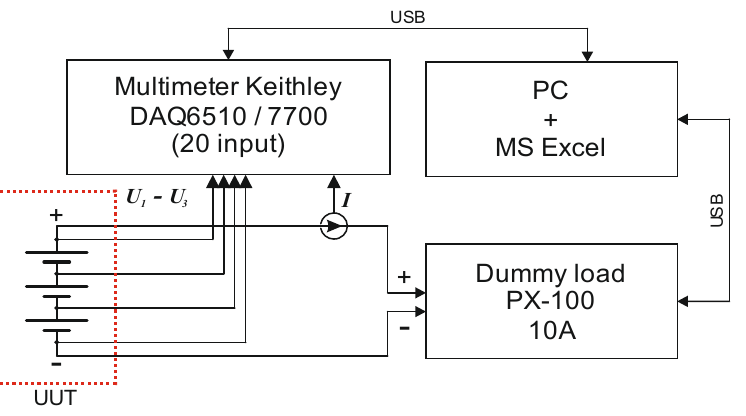
Figure 12. A block diagram of the measurement setup.